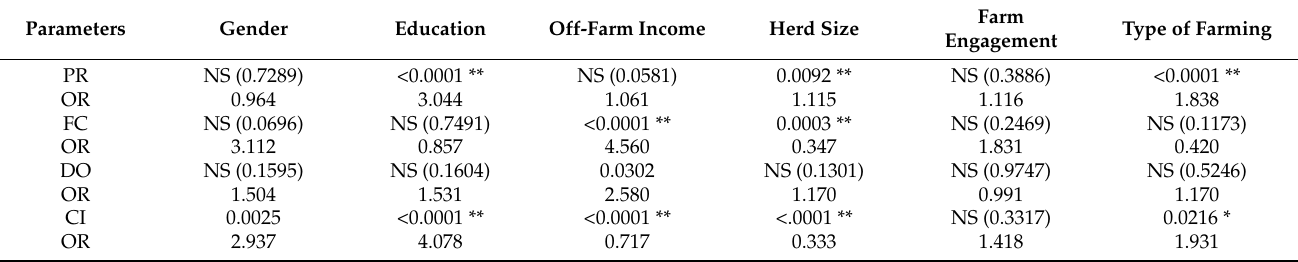
Table 8. Summary of association between herd dynamics and the odds of performance in smallholder beef cattle.